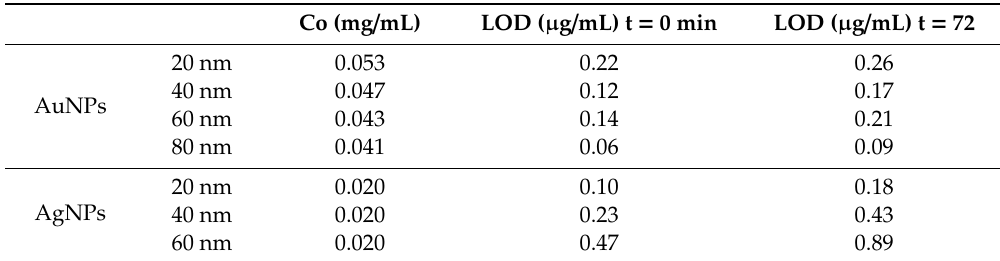
Table 2. Detection limits calculated for each diluted dispersions of citrate-capped AuNPs and AgNPs. Co (mg / mL)